Question: How would you classify this visualization?
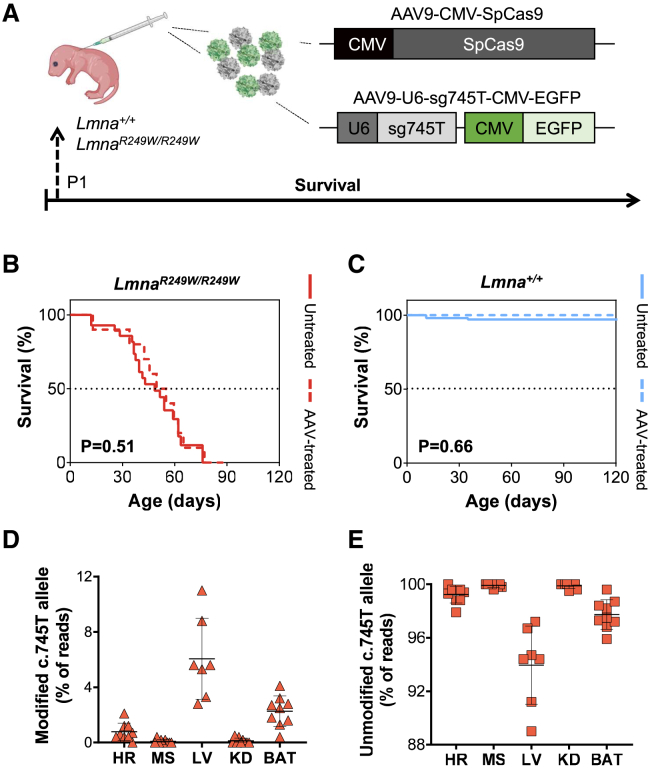
Answer: survival